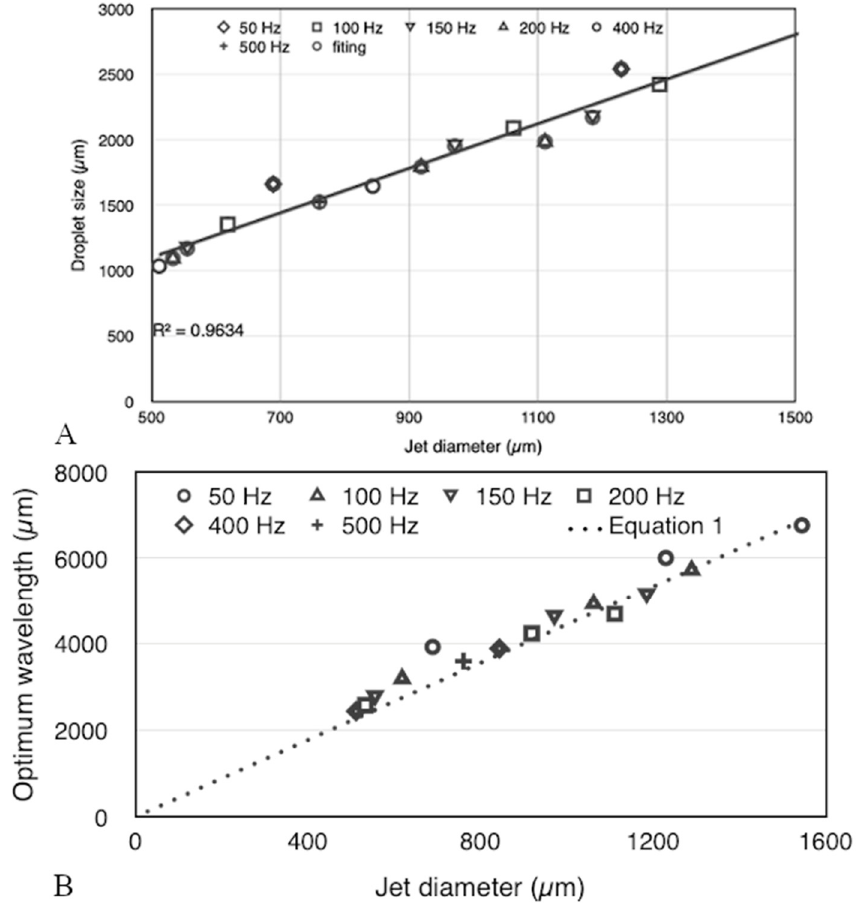
Figure 7. ( A ) Droplet size versus the jet diameter. ( B ) The optimum wavelength versus the jet